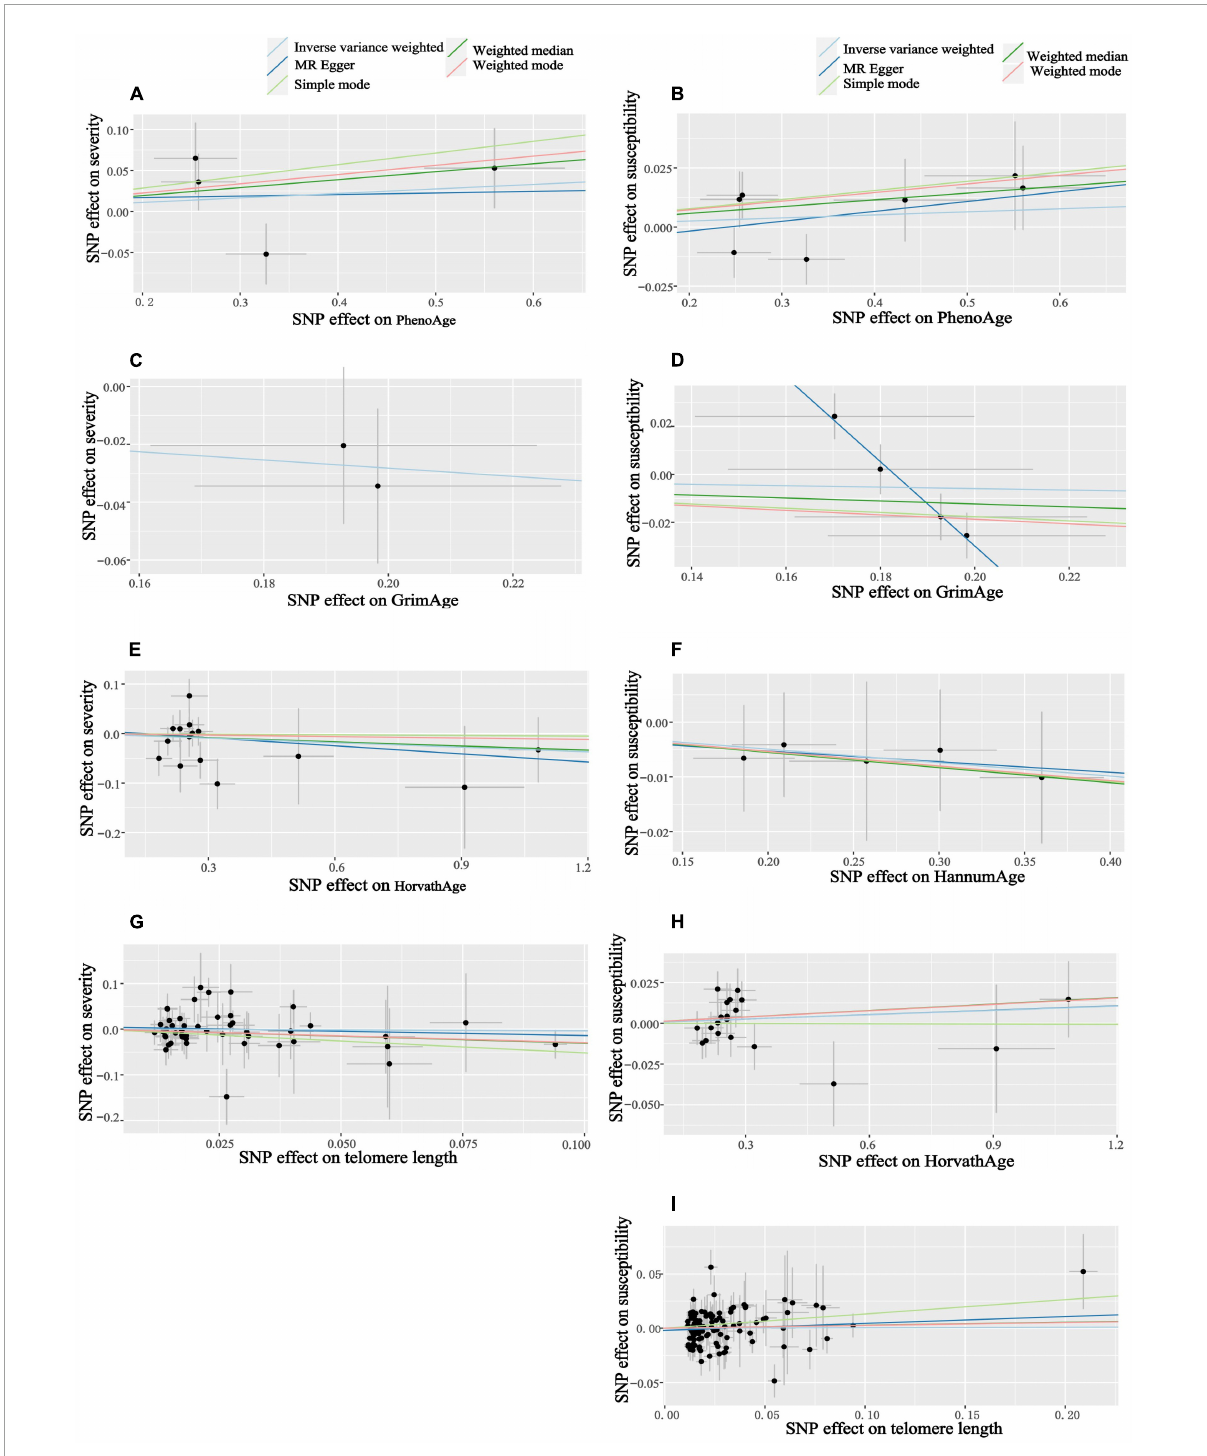
FIGURE4 Scatter plots of aging and COVID-19 susceptibility and severity. Horizontal ordinate: SNP effect on “exposure”; Vertical coordinates: SNP effect on “outcome.” (A) Exposure: PhenoAge, outcome: severity; (B) exposure: PhenoAge, outcome: susceptibility; (C) exposure: GrimAge, outcome: severity; (D) exposure: GrimAge, outcome: susceptibility; (E) exposure: HorvathAge, outcome: severity; (F) exposure: HannumAge, outcome: susceptibility; (G) exposure: telomere length, outcome: severity; (H) exposure: HorvathAge, outcome: susceptibility; (I) exposure: telomere length, outcome: